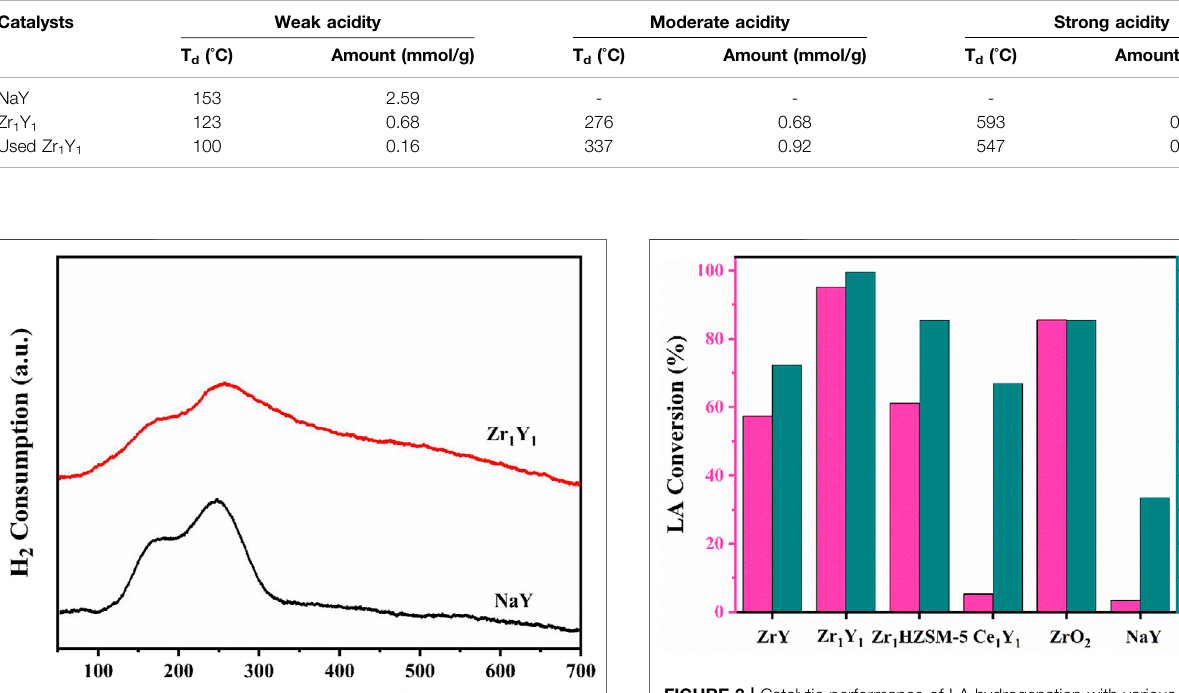
FIGURE 3 | Catalytic performance of LA hydrogenation with various